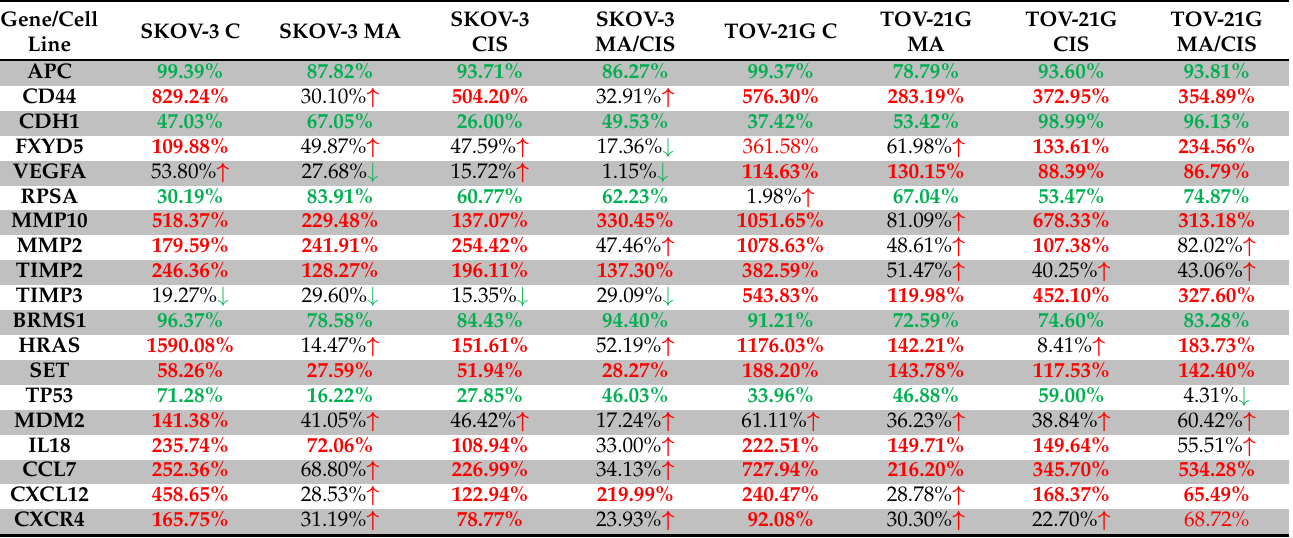
Table 2. Percentage change in gene expression level in fibroblasts under the influence of exosomes of various